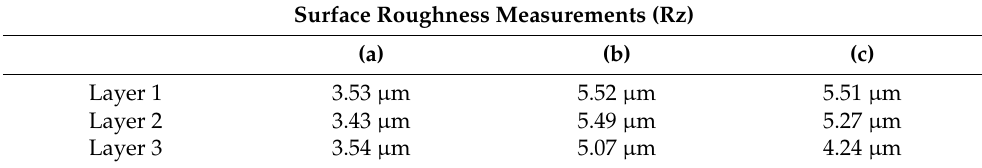
Table 4. Surface Roughness Measurements